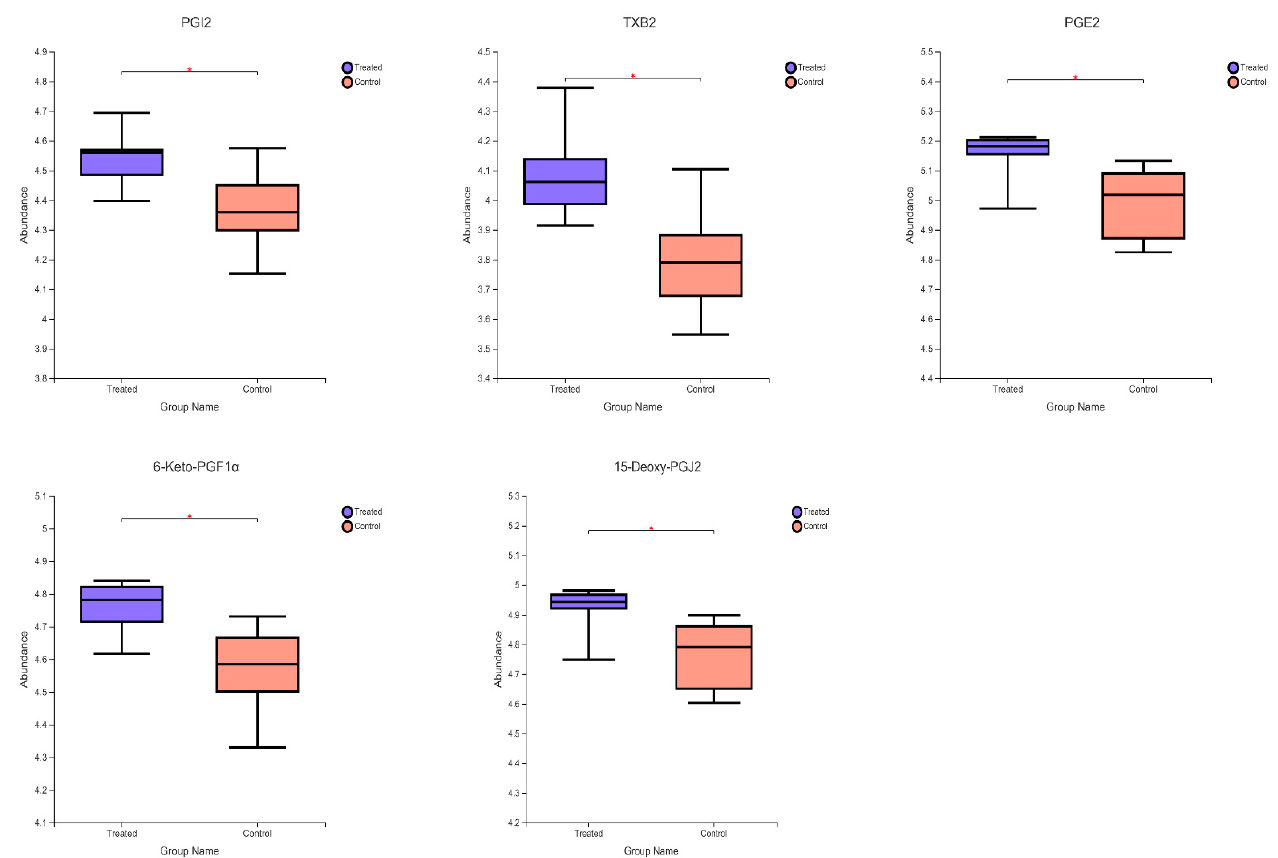
Figure 9. Relative abundance of arachidonic acid derivative prostaglandin I2 (PGI2), thromboxane (TXB2), 5-trans-PGE2 (PGE2), 6-Keto-prostaglandin F1alpha (6-Keto-PGF1 α ) and 15-deoxy- delta- 12,14-PGJ2 (15-Deoxy-PGJ2) ( n = 6). * p < 0.05. In maps, control represented control group and treated represented copper group.